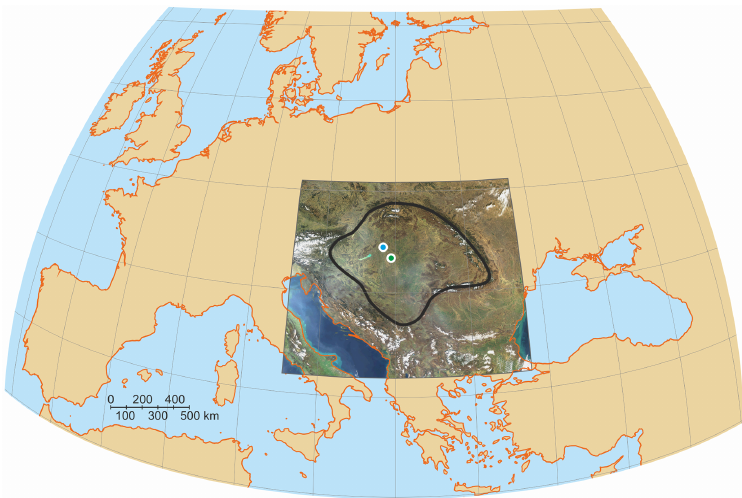
Figure 1. Image of the Carpathian Basin in central Europe retrieved from Aqua/MODIS data indicating the location and advantages of a well-separated basin (marked by black curve) and of the measurement sites in Budapest and at the K-puszta station (shown by blue and green dots,